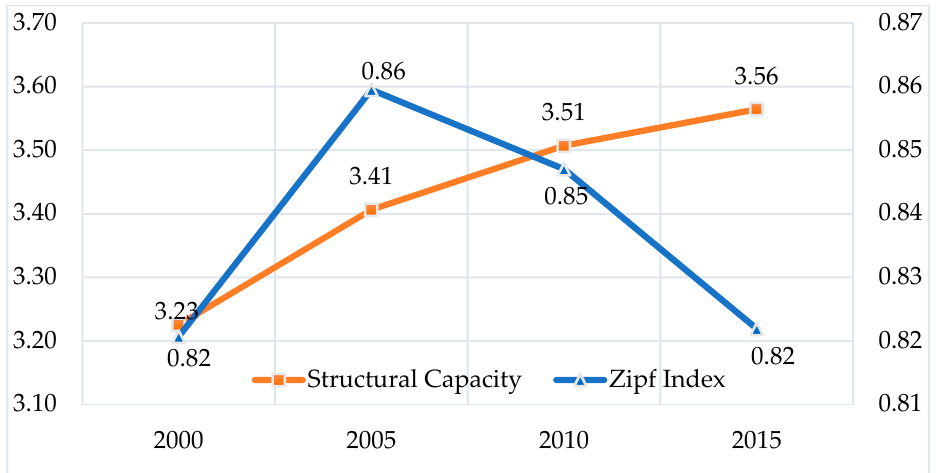
Figure 7. Cities' rank-size plots of China for 2000, 2005, 2010, 2015. The abscissa (x) is lg(R), where R stands for the city ranks of top200. The abscissa (x) is lg(R), where R stands for the city rank of top200. The vertical coordinates (y) is lg(S), where S stands for city size, namely urban area.